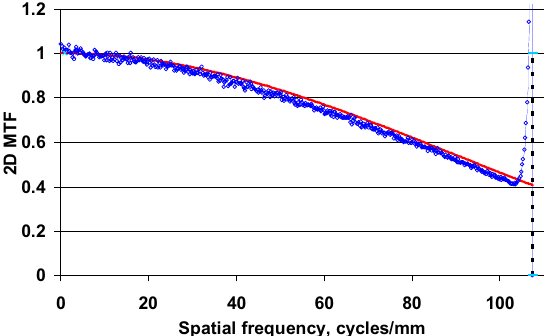
Fig. 4. Two-dimensional MTF: red solid curve depicts theo- retically calculated MTF (using Eq. (2)) and the blue scattered data is experimentally obtained at 535 nm